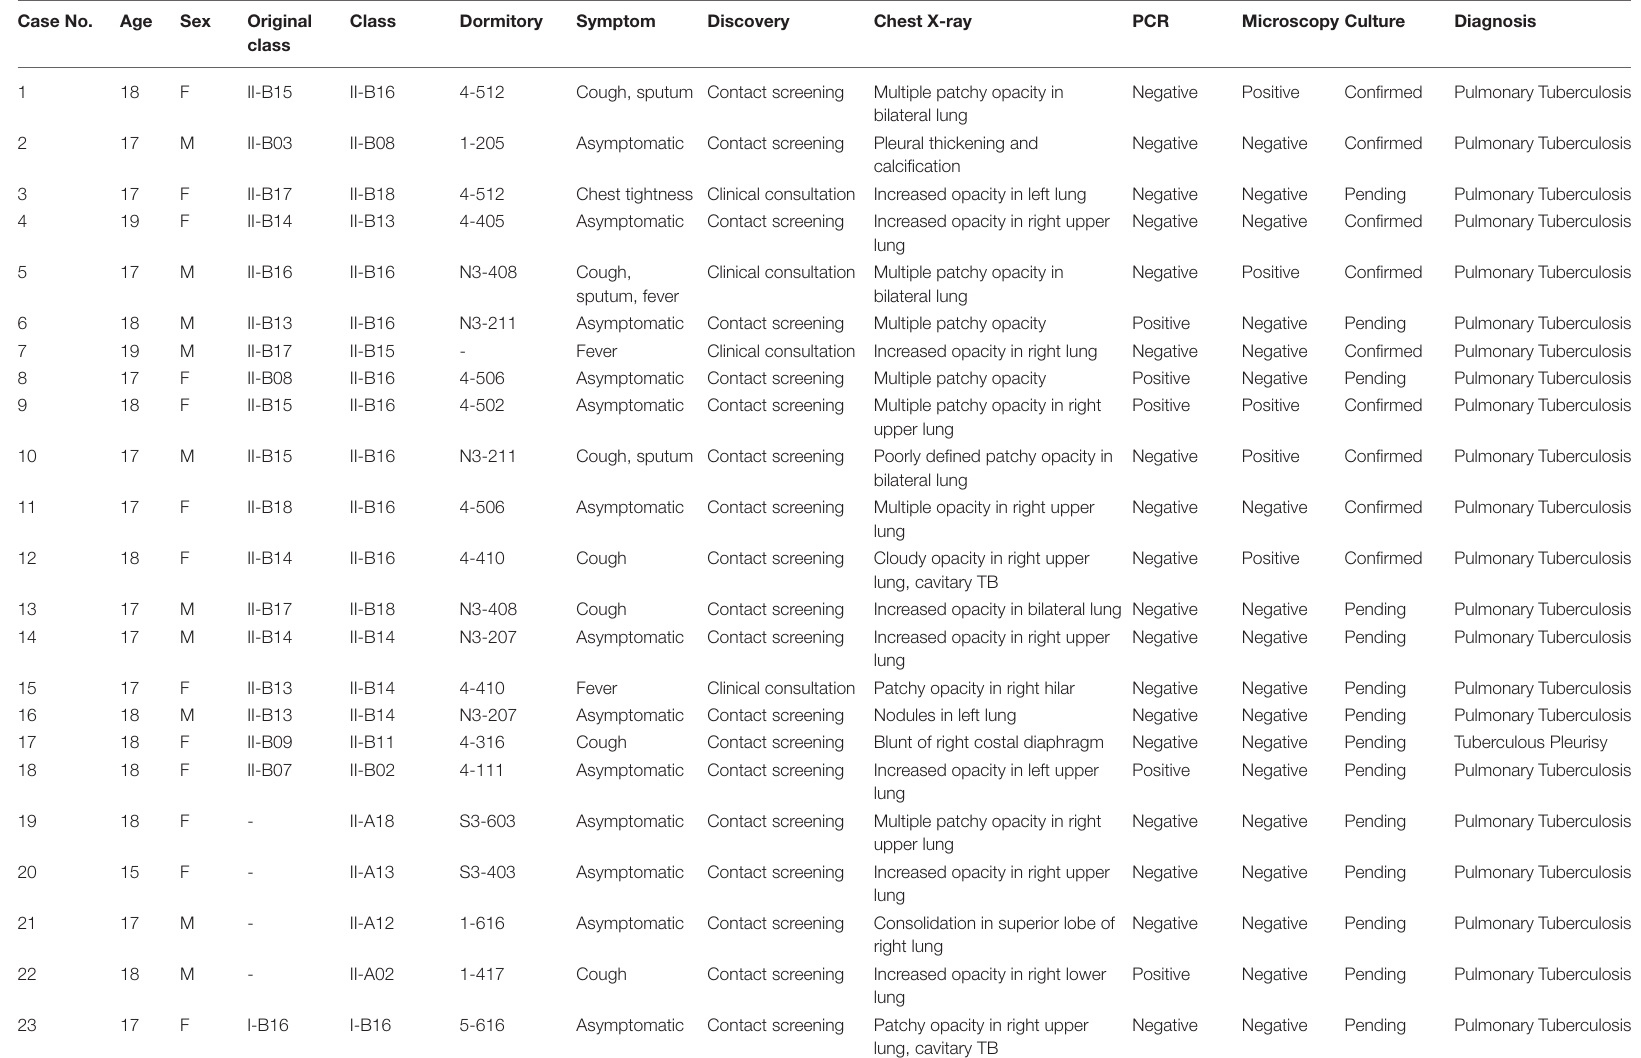
TABLE 2 | Individual details of the 23 cases of active pulmonary disease in Luoning High School, Henan, China, 2018. Case